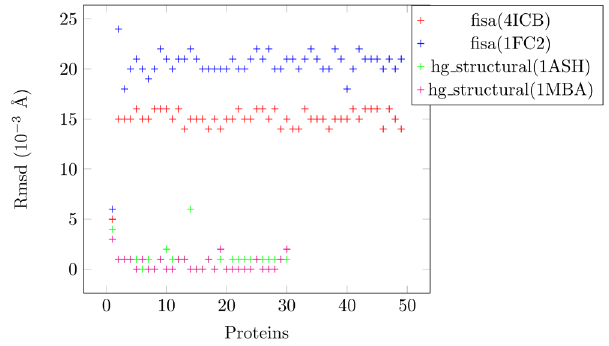
Figure 2. Root-mean-square deviation (RMSD) of the distance of consecutive C a (RDCC) atoms from the ideal value of 3.8 Å in decoy sets. The hg_structal and misfold decoy sets are indistinguishable using the distance discriminator, unlike the fisa decoy set. We have shown ~25 decoy structures from the fisa set, but the values apply to all the decoys (more than 500). The first protein (the native structure) in each set has RDCC below the 0.012 Å cutoff.